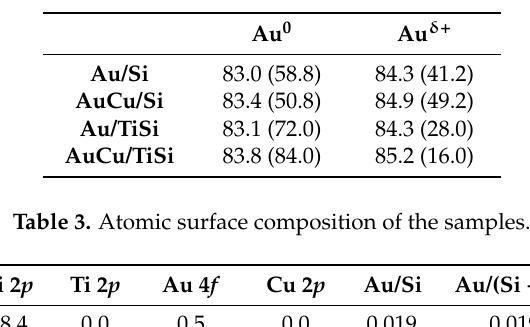
Figure 7. Au 4 f XPS spectra of mono and bimetallic samples. Table 2. Au 4 f 7 /2 binding energy (BE) values.